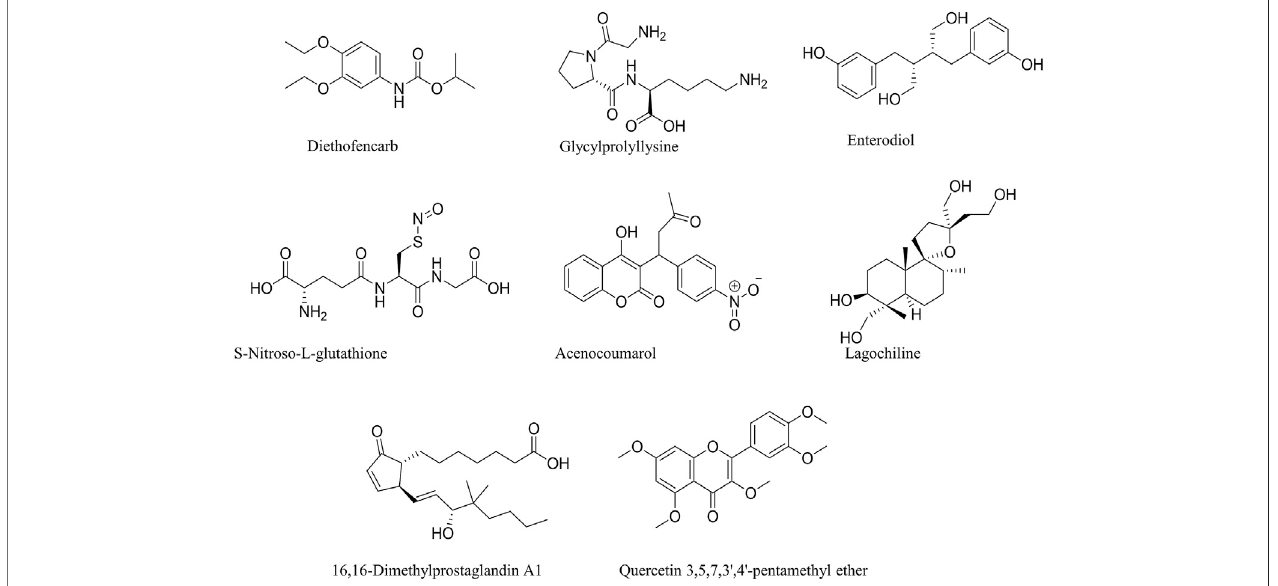
FIGURE 5 | Chemical structures of identi fi ed Compounds in M. conica .